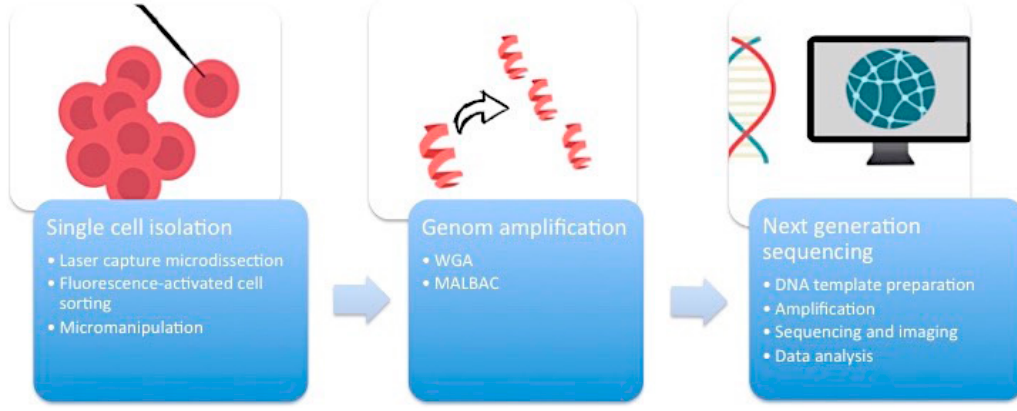
Figure 1. The work-flow of single-cell sequencing.